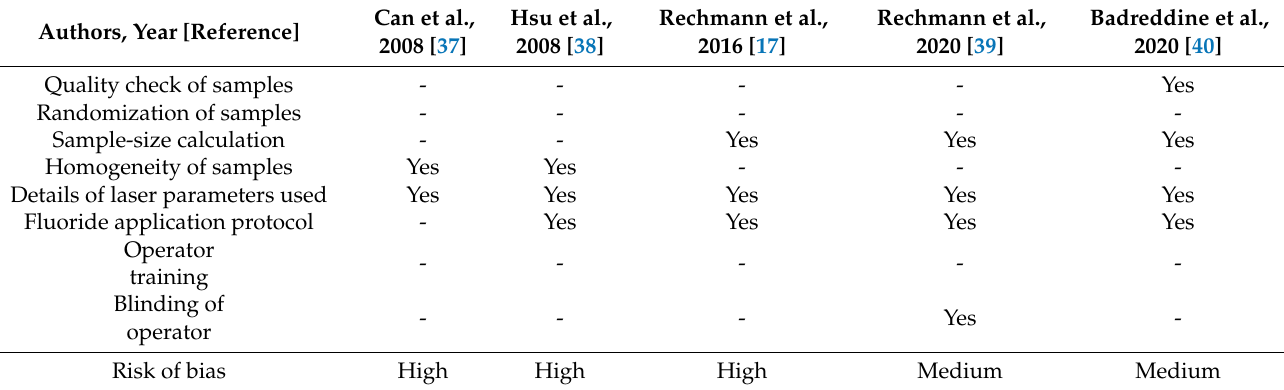
Table 3. Risk of bias of the included studies in the systematic